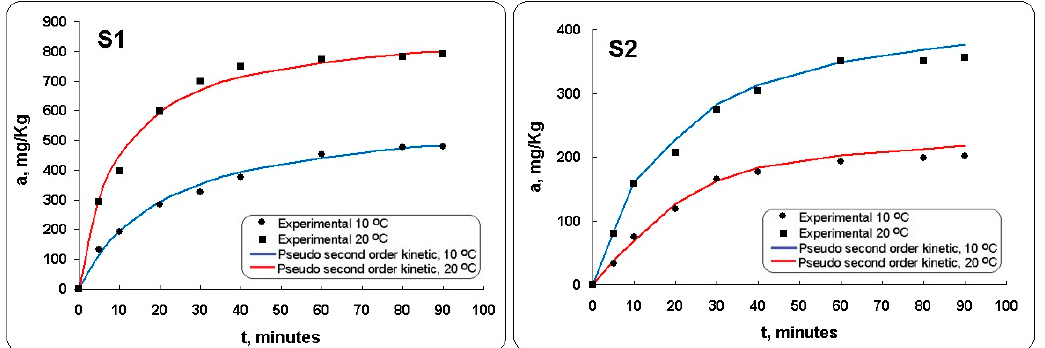
Figure 7. Integral kinetic curves for Mn 2+ retention on Mg-Al LDH (sample S1) and Mg-Al-Ni LDH (sample 2), at 10 and 20 ◦ C.